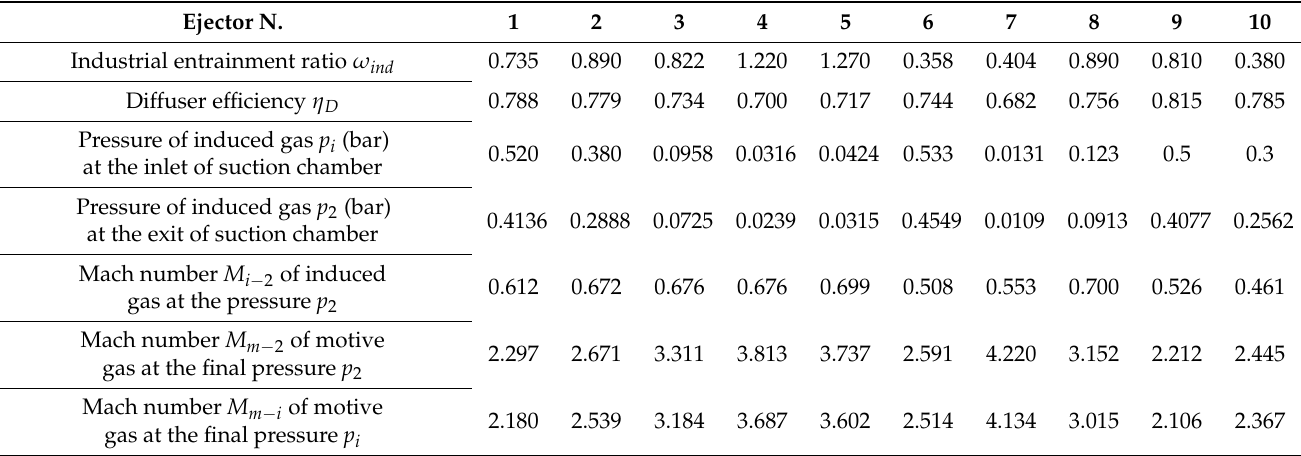
Table 4. Results of mathematical modelling applied to high-performance industrial ejectors to calculate diffuser